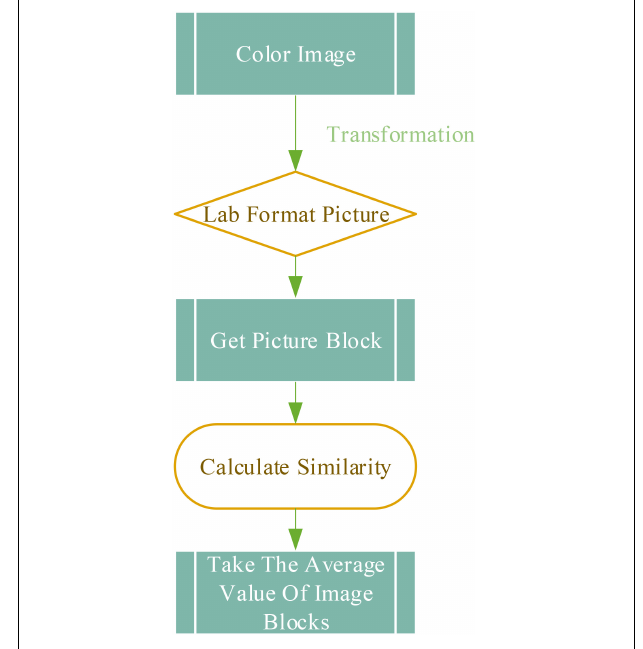
FIGURE 5 | Basic steps of